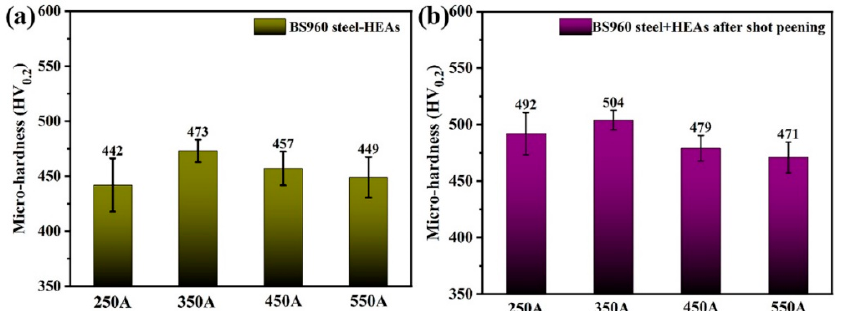
Figure 6. Micro-hardness values of FeCoNiCrMo 0.2 high entropy alloy coating sprayed by plasma at different currents ( a ) before shot peening, ( b ) after shot